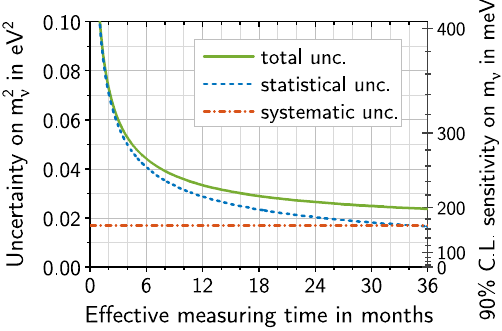
Fig. 19 The expected β -spectrum rate with different shaded areas depicting the fraction of scattered and unscattered electrons. The lower baseline comprises the 10 mcps energy-independent background com- ponent. Starting from the right, the shaded areas comprise signal β - electrons that are unscattered, scattered once, twice, and